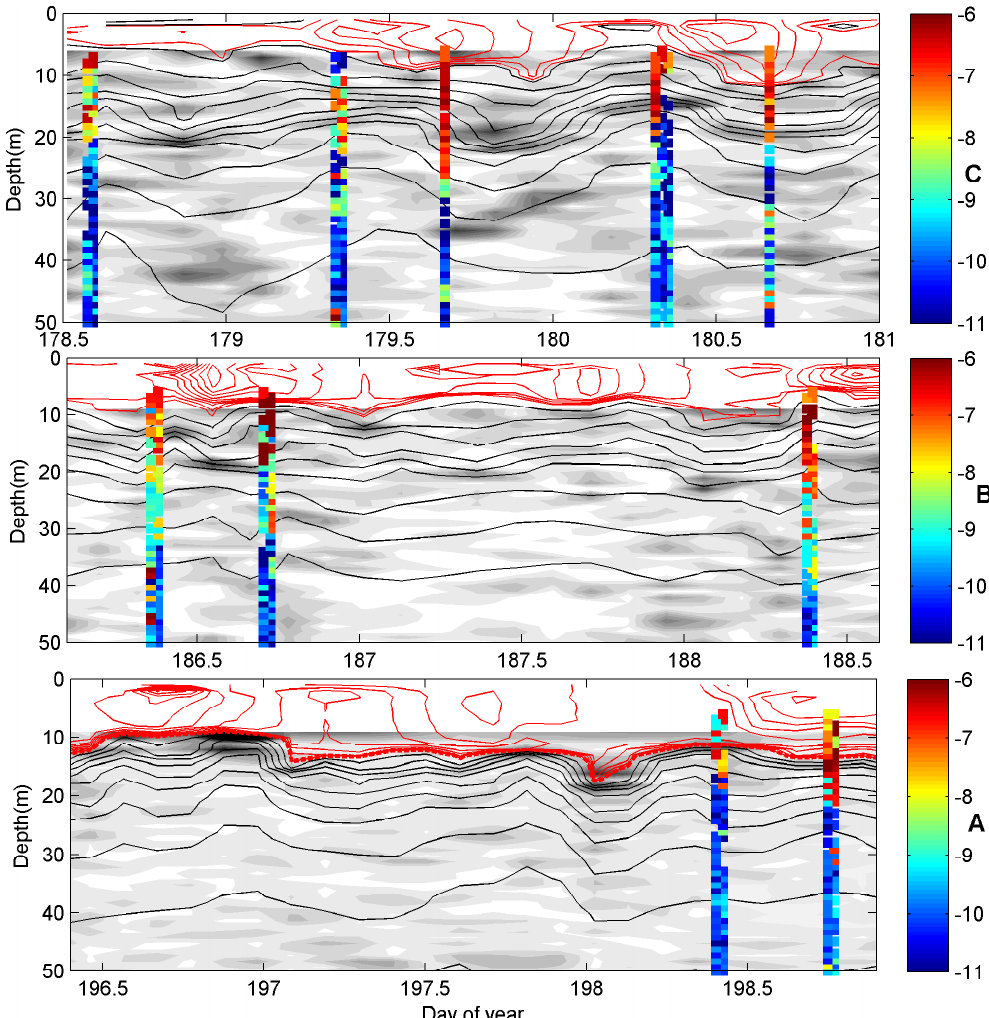
Fig. 5. Strain in gray scale (black high strain, white weak strain), 0.03kgm − 3 iso-density contours in the mixed layer in red lines, 0.2kgm − 3 iso-density contours below the mixed layer in black and TKE dissipation rates profiles in Log10 (Wkg − 1 ) in colored square marks, station C upper panel, station B middle panel, station A lower panel